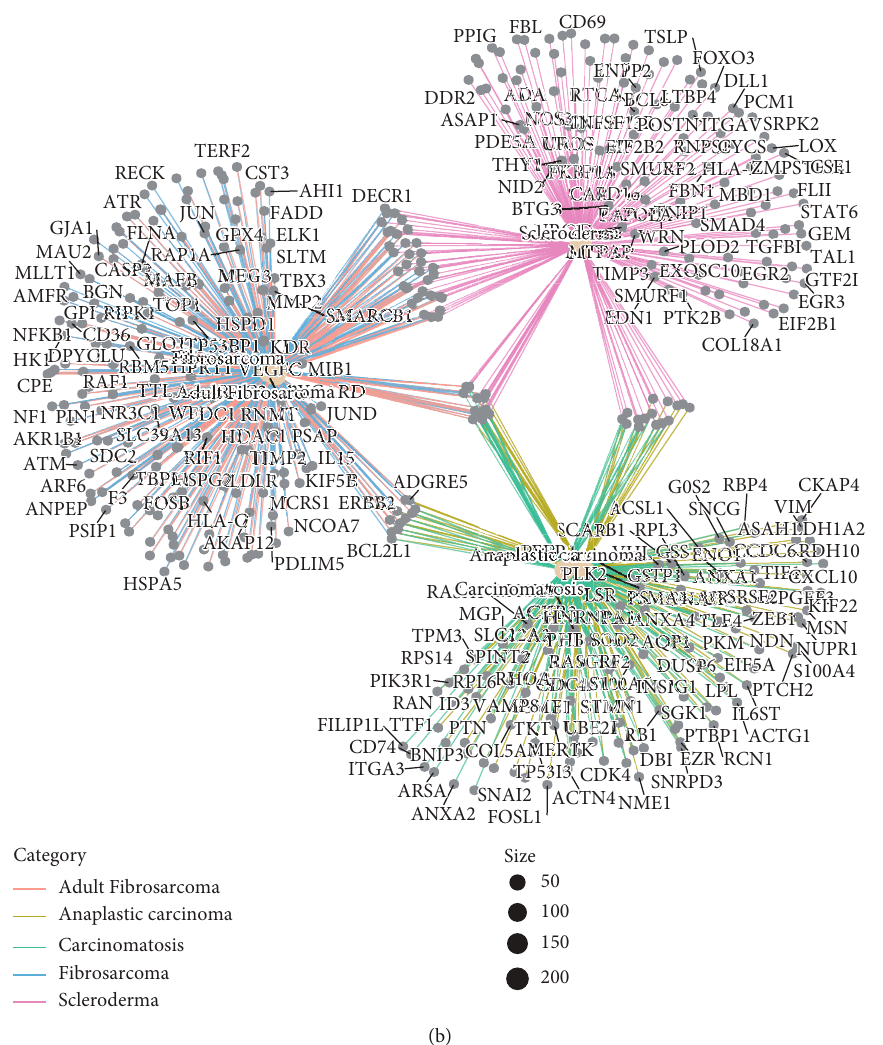
Figure 4: Endothelial cells in TNBC biopsies contribute to metastasis. (a) CNET plot shows the DEGS of EC (ATP1B3) and predicts metastasis. (b) CNET plot shows the DEGS of EC (HSPA1B) and predicts